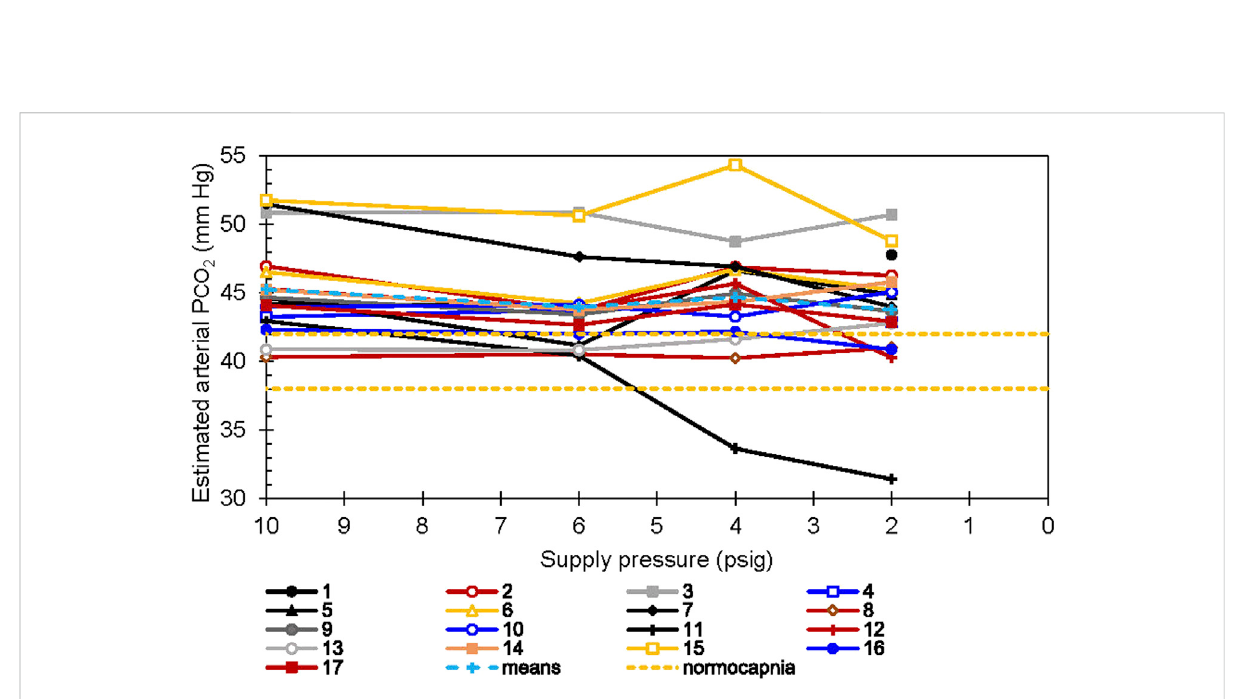
FIGURE 8 Minimum mask pressures vs . supply pressure. Each line represents a single